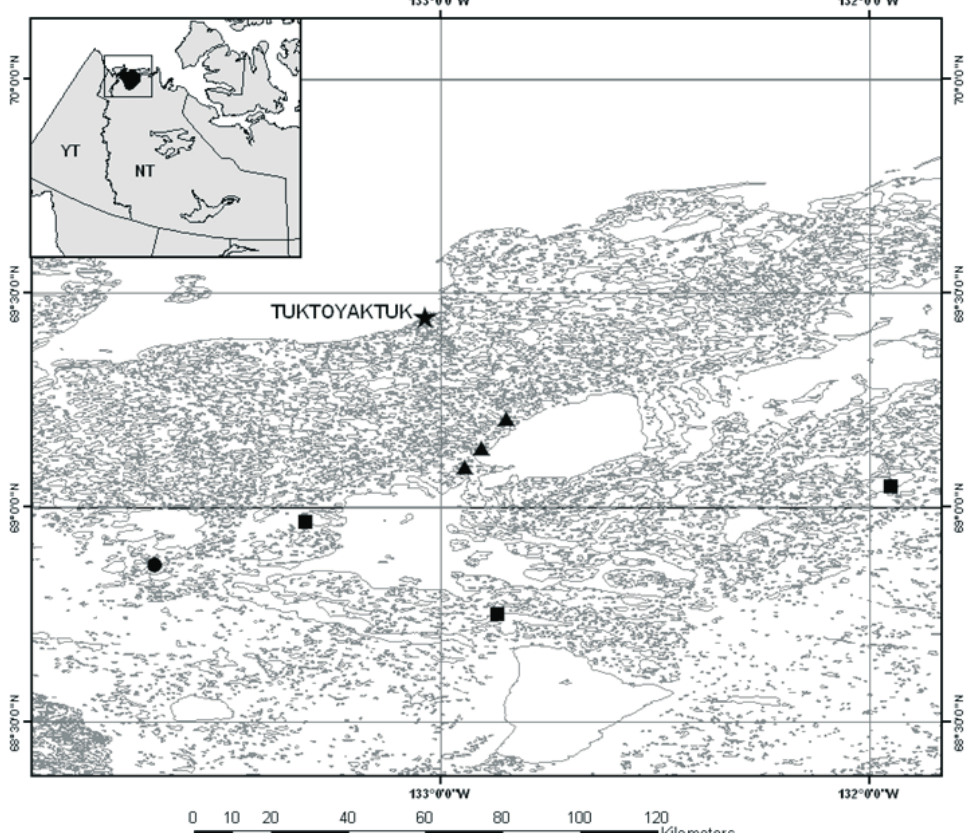
Fig. 1. The locations where caribou samples were collected south of Tuktoyaktuk, NT. Solid triangles (▲) winter 1994/95, solid squares (■) winter 2000/01, and the solid circle (●) winter 2001/02. Inset shows core Cape Bathurst caribou winter